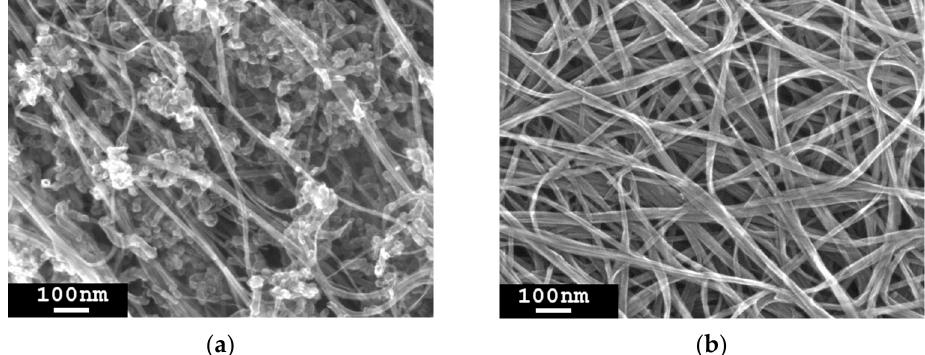
Figure 4. SEM images of acid treated and rinsed samples after mild oxidation before ( a ) and after ( b ) heat treatment at 480 ◦ C for 6